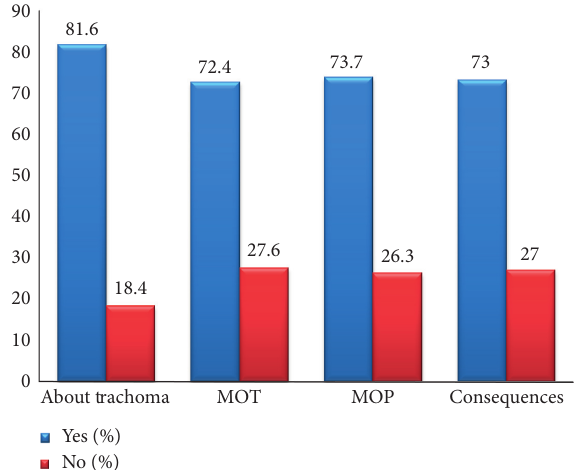
Figure 1: Caretakers knowledge towards Trachoma in in Areka Town in Southern Ethiopia, 2018.